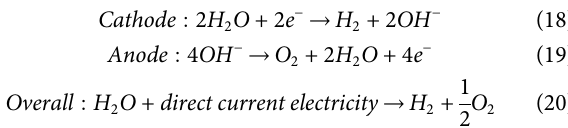
Overall : H 2 O + direct current electricity → H 2 +